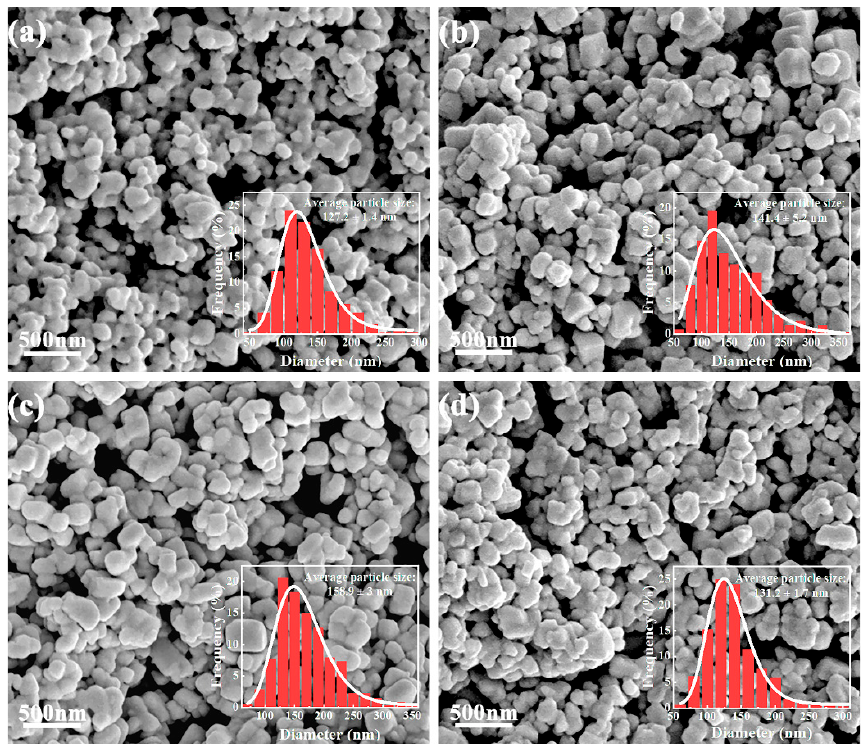
Figure 2. SEM images of Ba 1 ‐ x Sr x TiO 3 nanopowders with different x: ( a ) x = 0; ( b ) x = 0.1; ( c ) x = 0.2; ( d ) x = 0.3. ( d ) x =